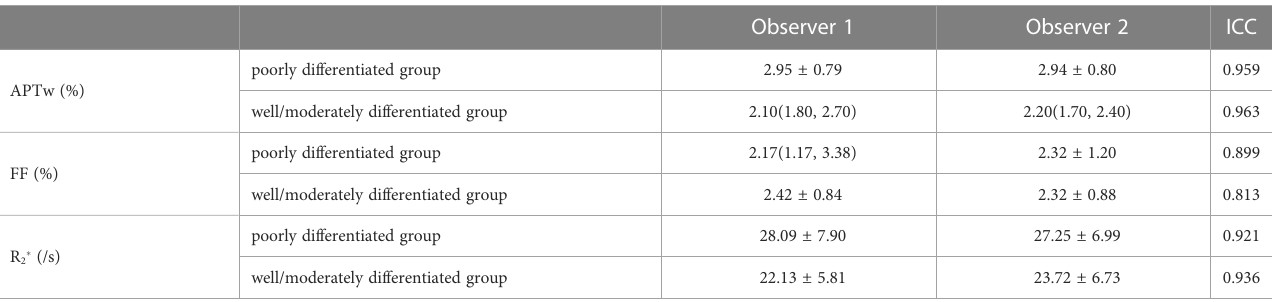
TABLE 3 APTw, FF, and R (cid:1) 2 measurement consistency between two observers.